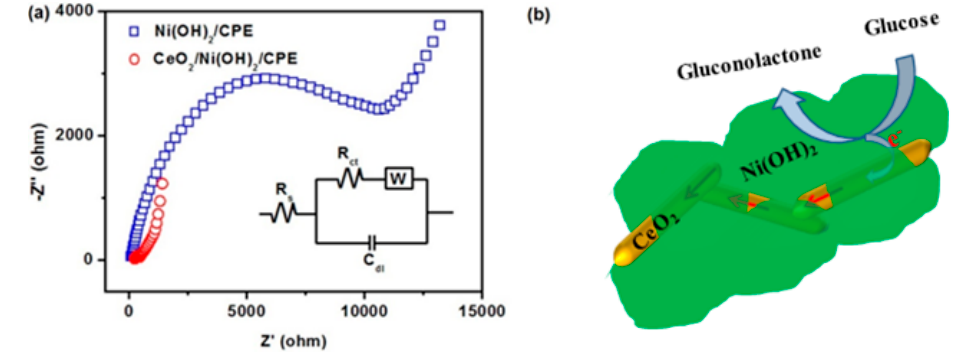
Figure 5. ( a ) Nyquist impedance plots for Ni(OH) 2 /CPE and CeO 2 /Ni(OH) 2 /CPE recorded in 0.1 M KCl solution containing 1 mM Fe[(CN) 6 ] 3 − /4 − (1:1); ( b ) Schematic diagram of sensing mechanism of CeO 2 /Ni(OH) 2 nanocomposite.